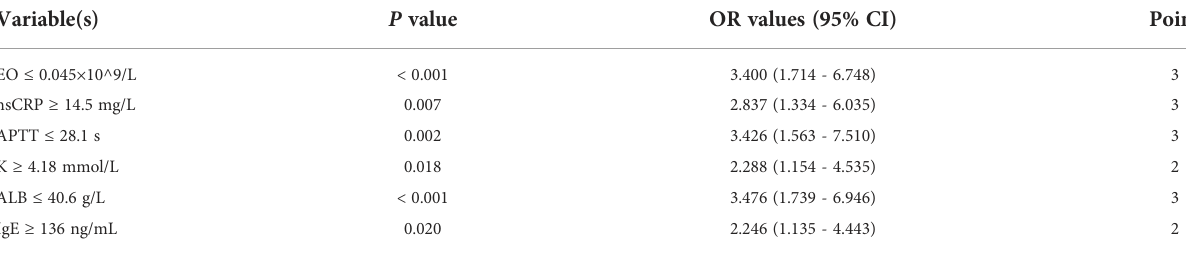
TABLE 4 OR values and scores of binary logistic regressions in the training set. Variable(s)